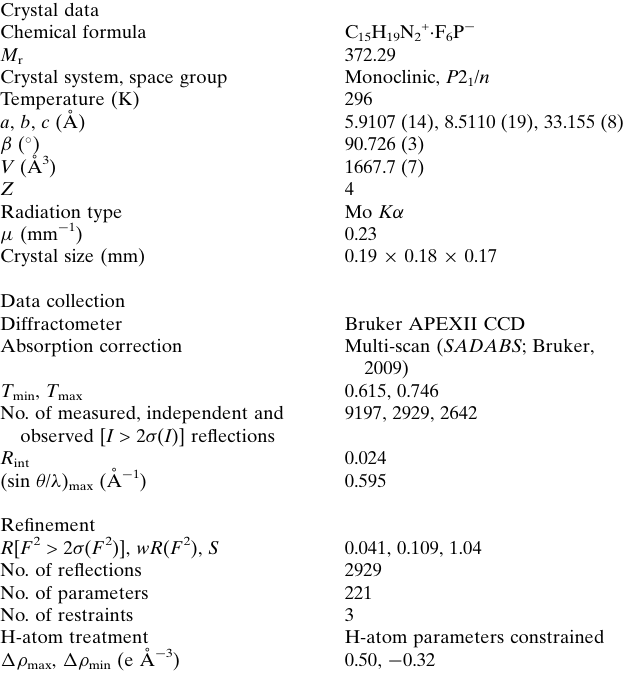
Table 2 Experimental details.